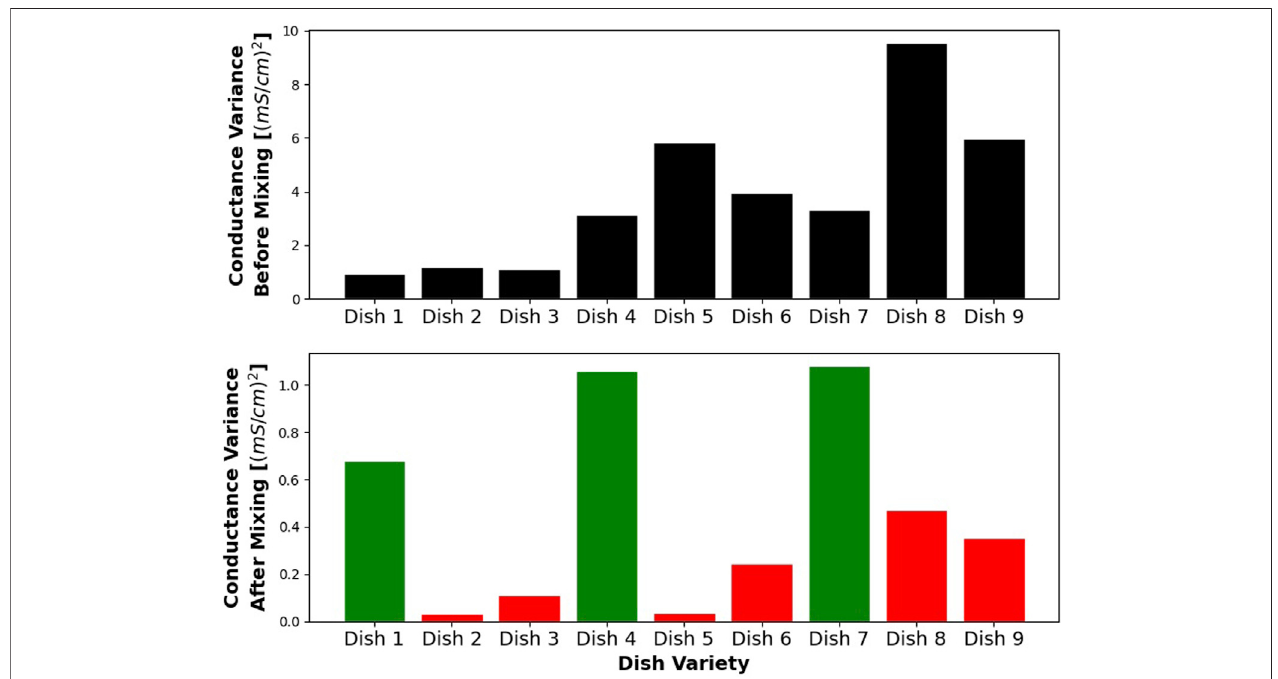
FIGURE 7 | Figure showing the variance of salinity measurements, before and after mixing, for each dish. Dishes including tomato (red) tend to have much lower variance after mixed.